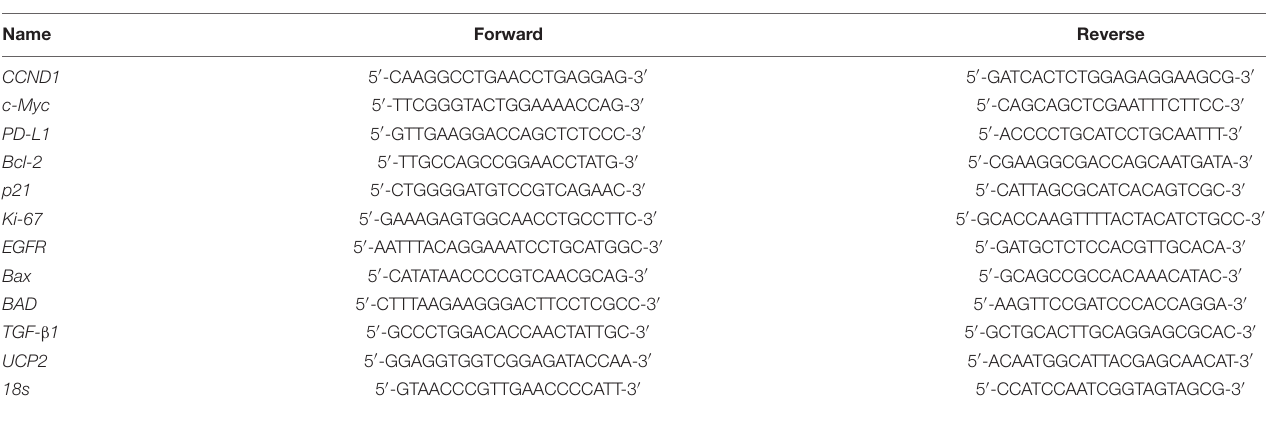
TABLE 1 | Primer sequences for the